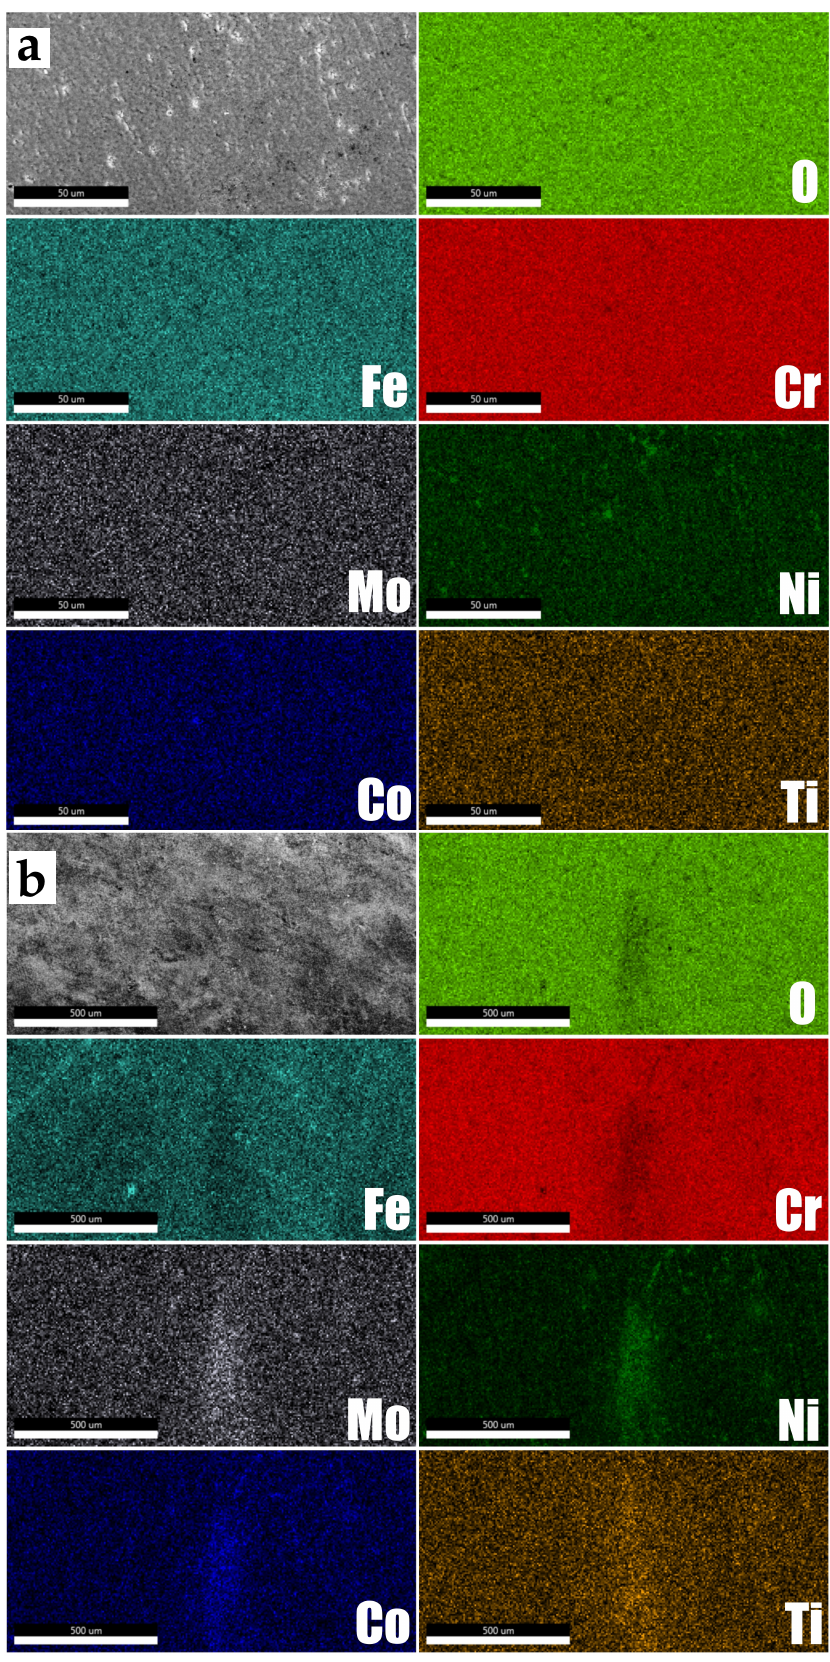
Figure 8. Surface SEM micrograph post-steam-oxidation of: ( a ) IN 617 AR; ( b ) IN 617